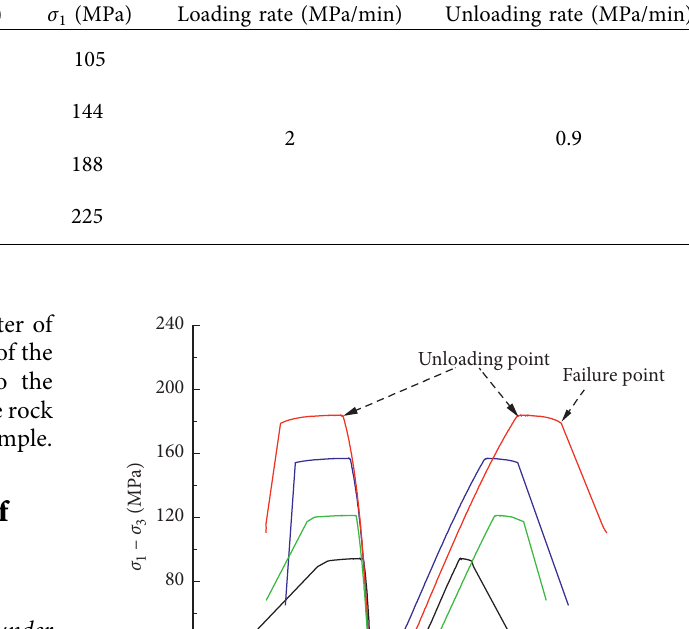
Table 1: Initial stress state of rock samples.